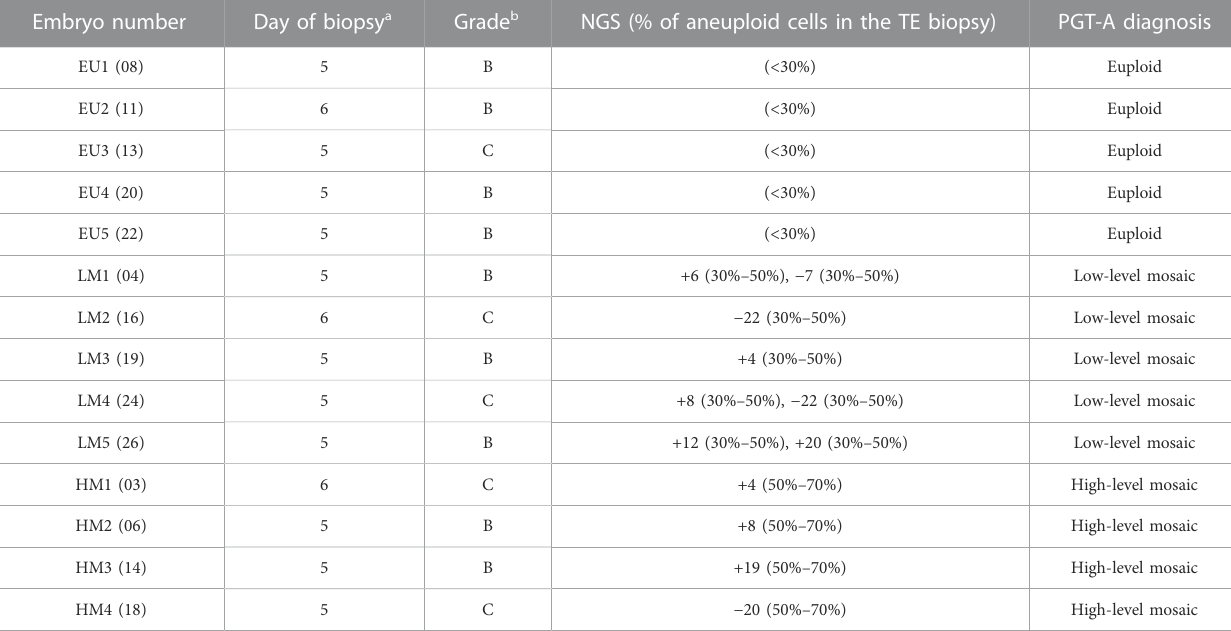
TABLE1Studypopulation andembryo characteristics.PGT-Awasperformedbynext-generationsequencing(mosaicrangede fi nedbetween30% – 70%aneuploid cells). a Days post-fertilization. b Embryo quality assessed accordingto guidelines from the Spanish Association for the Study of Biology of Reproduction (ASEBIR). Embryo